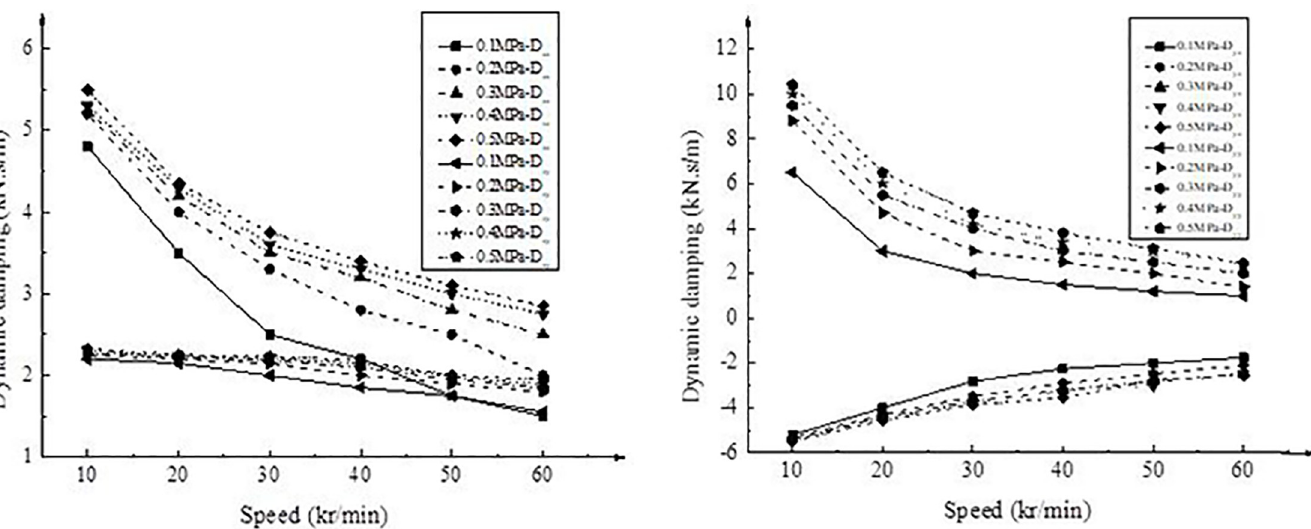
PLOS ONE | https://doi.org/10.1371/journal.pone.0244403 March 15,